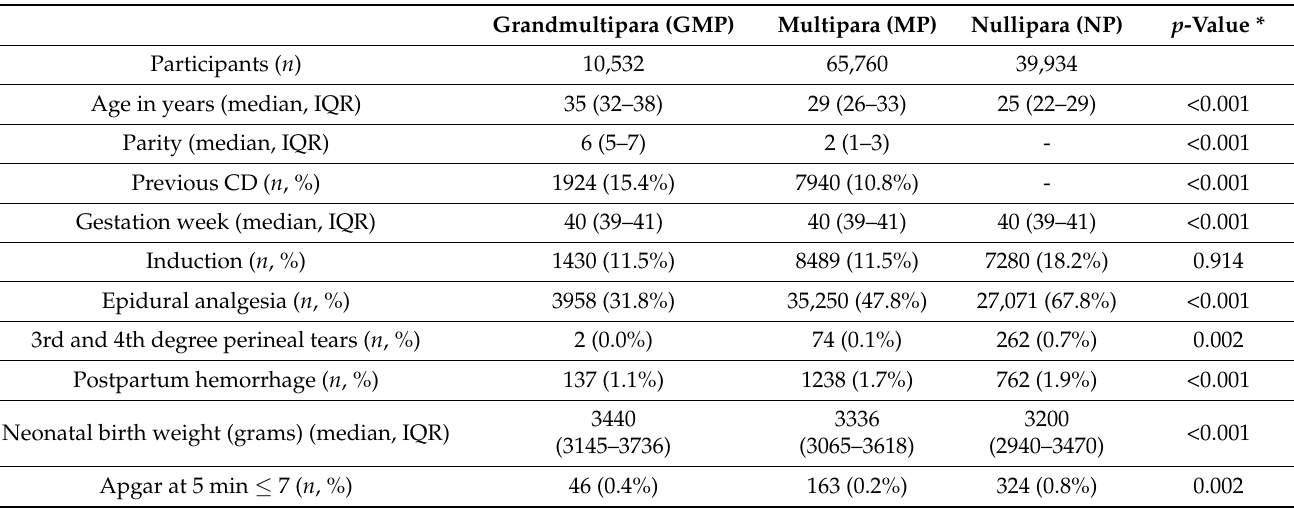
Table 1. Obstetric parameters of parturients with twins and singleton deliveries.